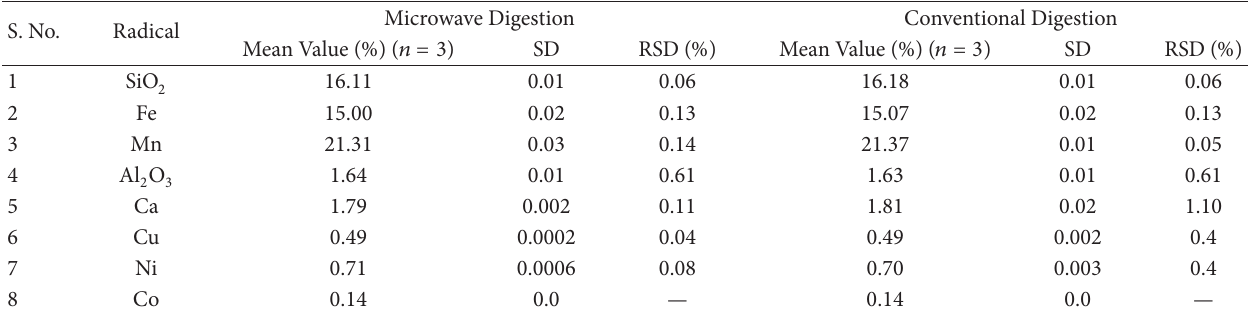
T 6: e Standard Deviations and Relative Standard Deviation of measurement for radical concentrations of microwave and conventionally digested